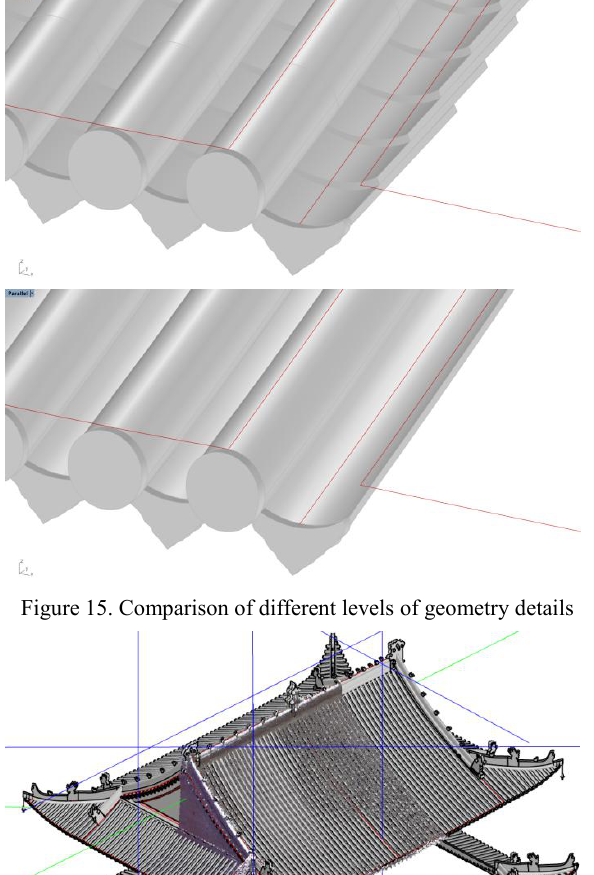
Figure 18. “Butterfly” tiles